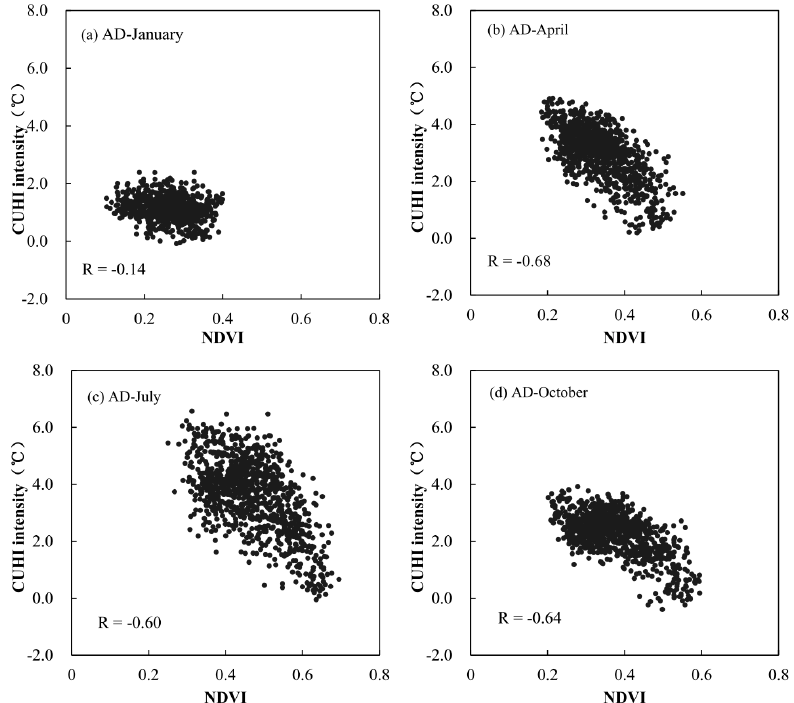
Figure 12. Scatter plots of daytime-CUHI intensity vs. NDVI for four representative months during the period 2002–2013 at Aqua daytime overpass. ( a ) January; ( b ) April; ( c ) July; and ( d ) October.